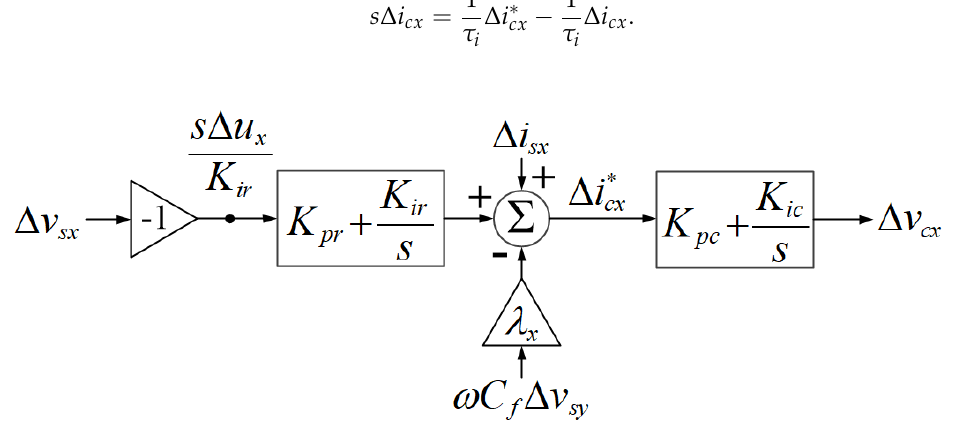
Figure 2. Controller of wind farm side voltage-source converter